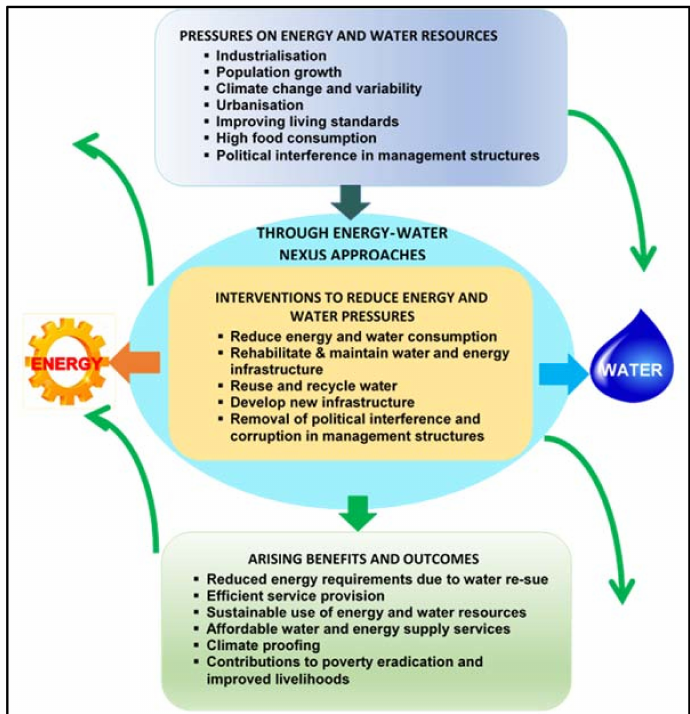
Figure 8. Energy-Water Action Plan conceptual framework. Source: Adapted from The World Bank